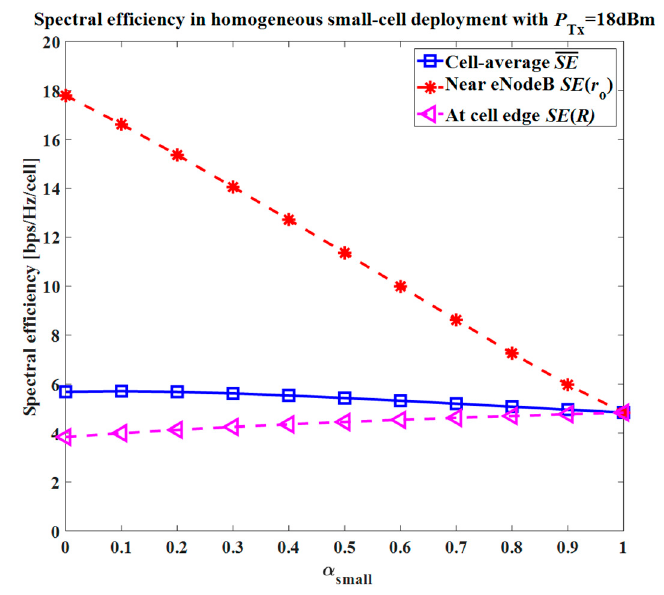
Figure 10. Spectral e ffi ciency for small cells as a function of distance and α small in homogenous small cell